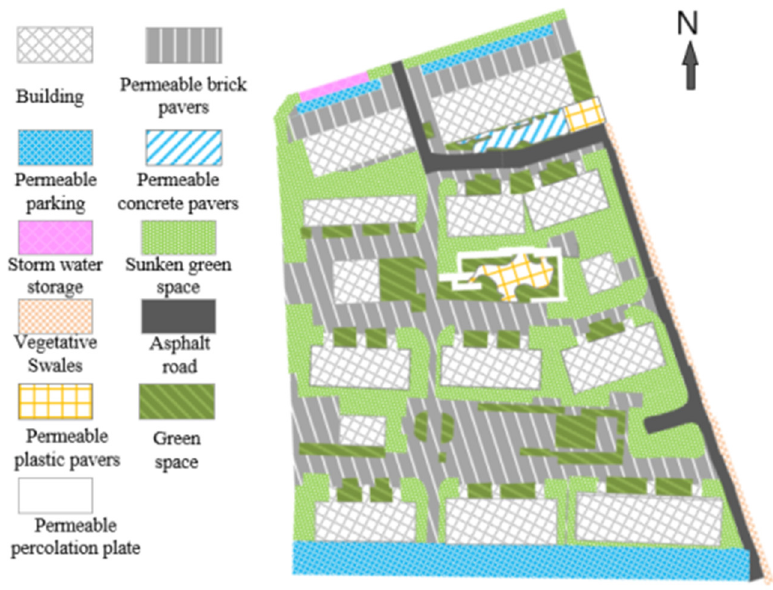
Figure 2. Land use classification.